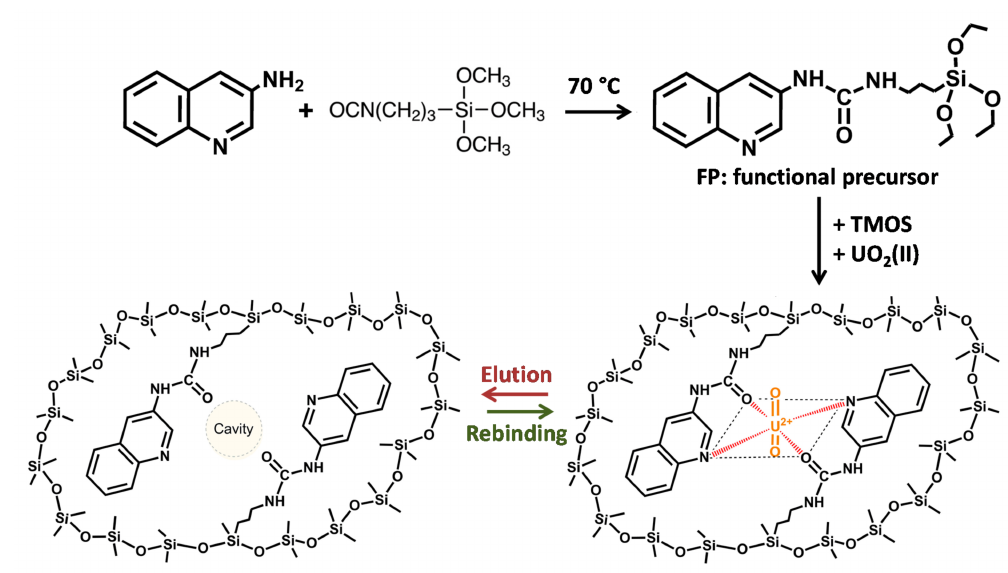
Figure 19. Synthesis of IISG from quinolone-functionalized silane, TMOS and uranyl. Adapted with permission of Elsevier from